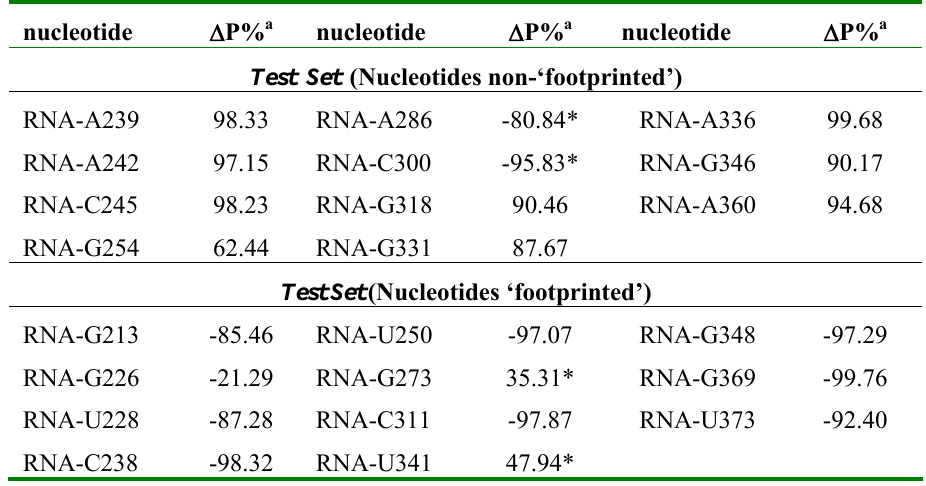
Table 4. Test set classification